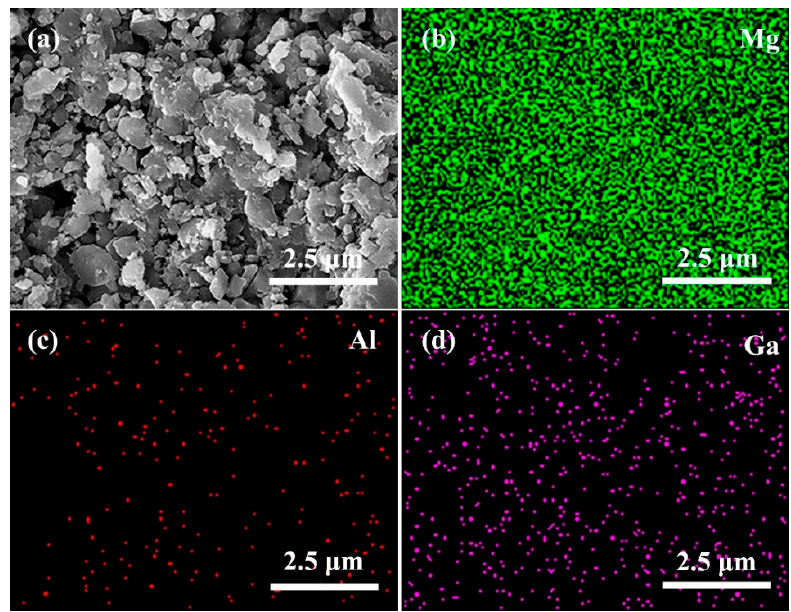
Figure 4. ( a ) SEM diagram of sample after sintering, ( b – d ) EDS mapping of Mg, Al, Ga.